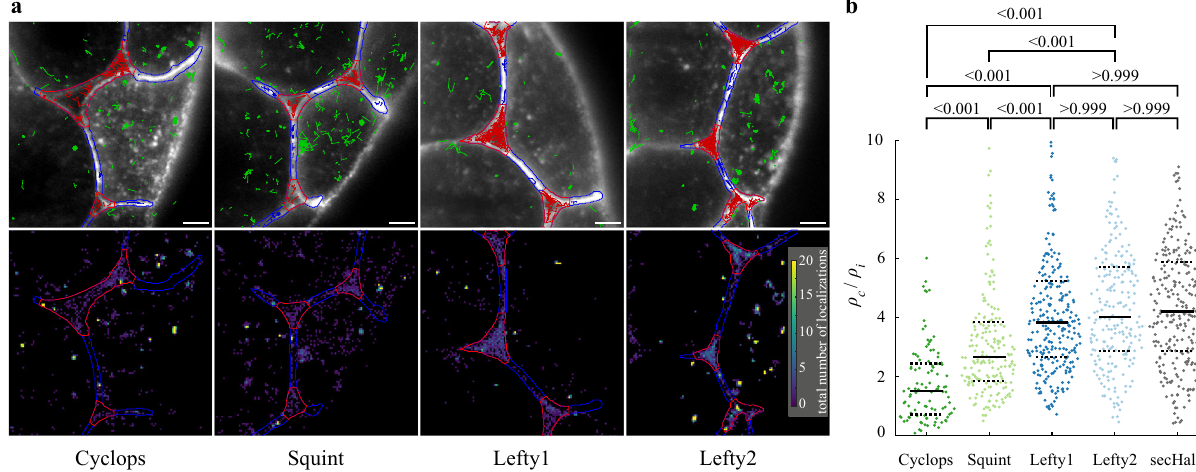
Fig. 2 | Localization of morphogens in cell-cell interfaces and extracellular cavities.a Top:OverlayofthememGFPsignal,themanuallycuratedROIseparating cell-cell-interfaces (blue, I) and extracellular cavities (red, C); tracks assigned to interfaces (blue), cavities (red) and not assigned (green) are also shown. Bottom: Tracking-and-localization-microscopy (TALM) image showing the total number of localizations over 1000 frames or 11.7s in each 2×2 pixel bin; scale bar: 5 µ m. b Ratiosoflocalizationdensitiesincavitiesandinterfacescalculatedforeachmovie